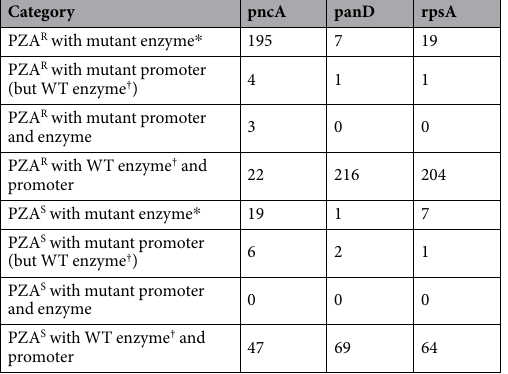
Table 3. Frequency of mutations in pncA and its promoter, panD and its promoter, and rpsA and its promoter in M. tuberculosis clinical isolates. WT = wild-type. * Includes heterogeneous variations (i.e. mixed populations with mutant and WT gene/promoter). † Also includes isolates that harbor synonymous mutations (only) in the